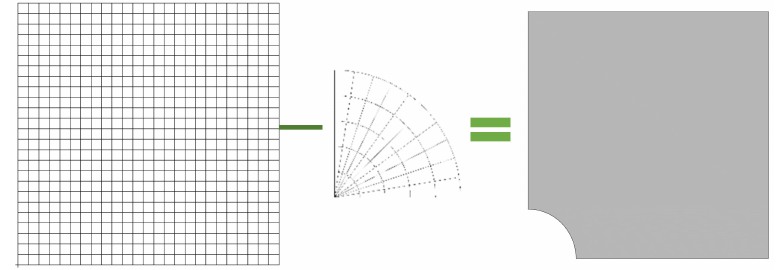
Figure 10. Discretization of RSUB with node interval h =